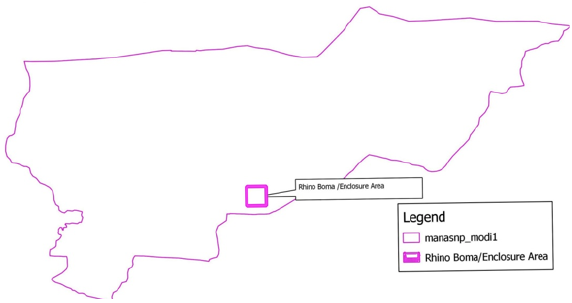
Figure 1. Showing sites of Rhino Boma/Enclosure